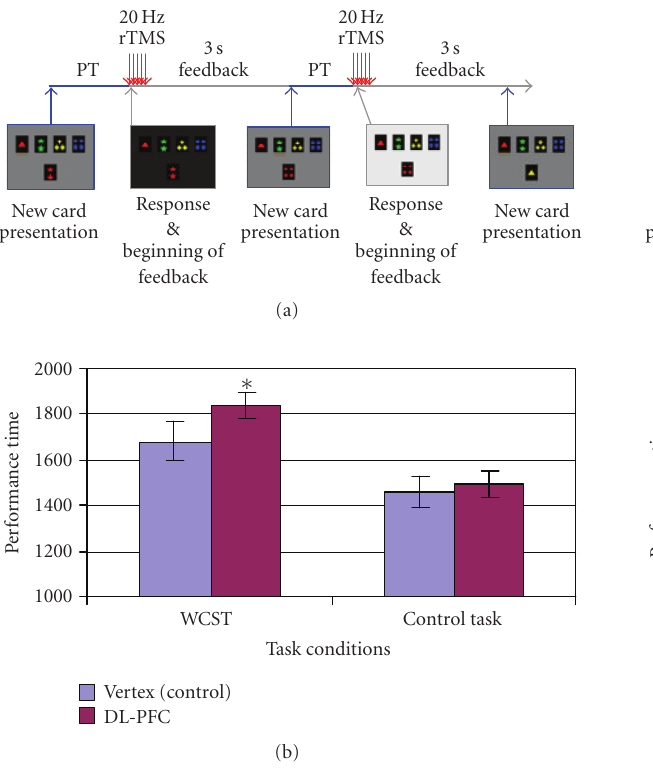
Figure 5: (a) rTMS at the beginning of matching: while the subject performed the WCST or control task, rTMS was applied over the right DL-PFC or vertex at the beginning of matching. (b) DL-PFC stimulation during the matching phase of WCST or control task had no e ff ect on PT compared to the vertex